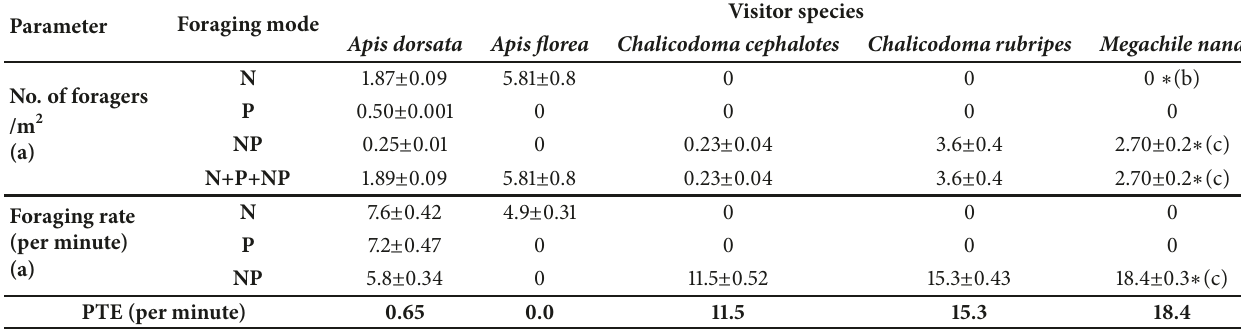
Table 5: Foraging modes, number of foragers, foraging rates, and pollen transfer efficiency of different flower visitors of alfalfa ( Medicago sativa ).